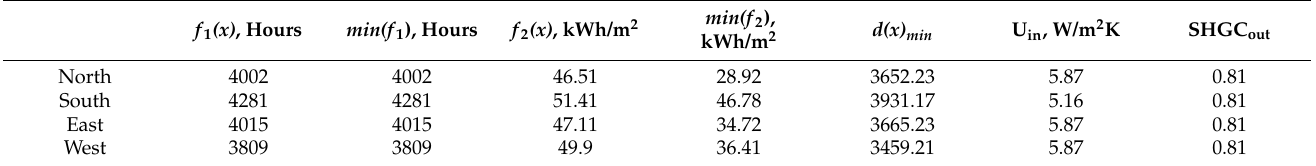
Table 8. Summary of numerical outcomes for the optimal solutions—Sydney.